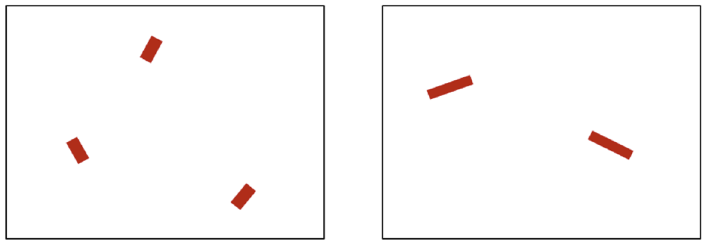
Figure 1b. A size-number incongruent trial in the small numerosity condition in Experiment 1.